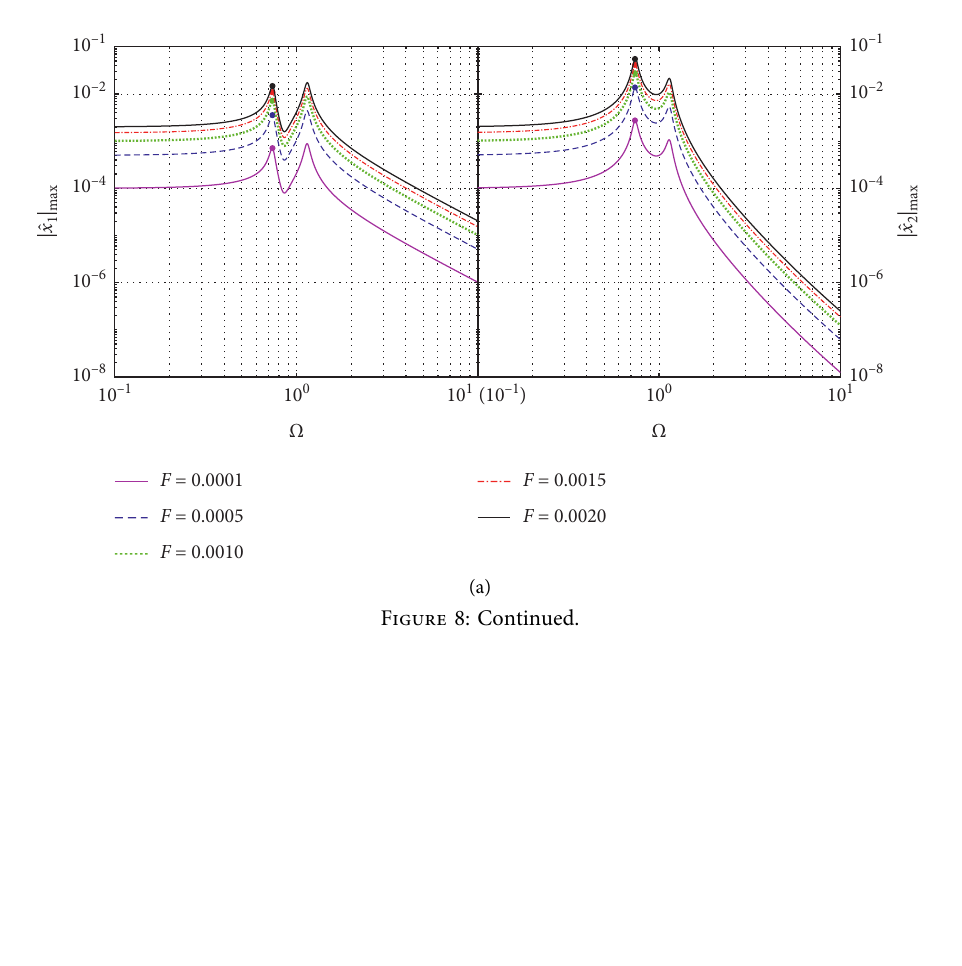
Figure 7: The forced responses of a type III two-stage isolator in primary resonance, for 􏽢 k motions on the approximate NNM invariant manifold for the underlying conservative system. (a) Displacement amplitude-frequency responses for the payload and the ones for the lower stage of the isolator under force excitations with increasing frequency and different amplitude F : pink solid line represents F � 0 . 0001; blue dashed line represents F � 0 . 0005; green dotted line represents F � 0 . 0010; red dashed-dotted line represents F � 0 . 0015; black solid line represents F � 0 . 0020; the other parameters of the system are the same as in Figure 2. (b) Five representative forced responses in primary resonance of the system shown in different line styles, which correspond, respectively, to the solid points on the curves in (a) with the same color and line style. Five free periodic motions of the underlying conservative system are shown in solid lines. In the neighborhood of each periodic trajectory, the corresponding forced response orbit evolves. (c-d) The approximation of the NNM invariant manifold for the displacement constraint 􏽢 x five free periodic trajectories in (b) are also presented in solid lines in (c) and (d); η space of generalized modal